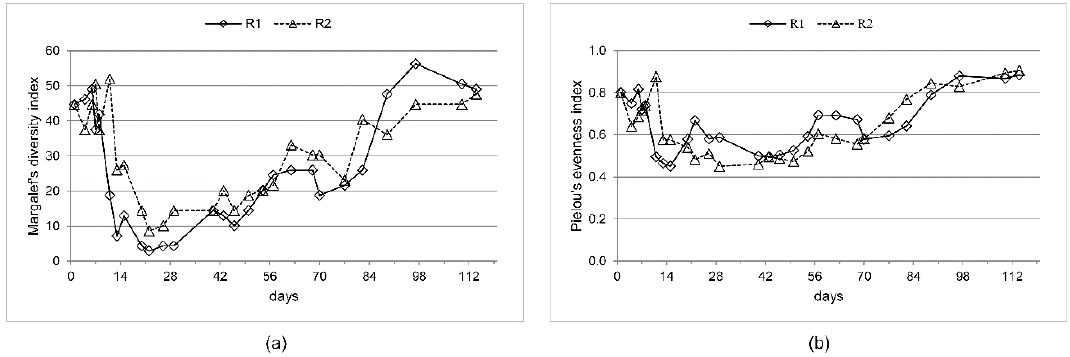
Figure 6. bacterial community, as measured by T-RFLP. ( a ) Richness; and ( b ) evenness.